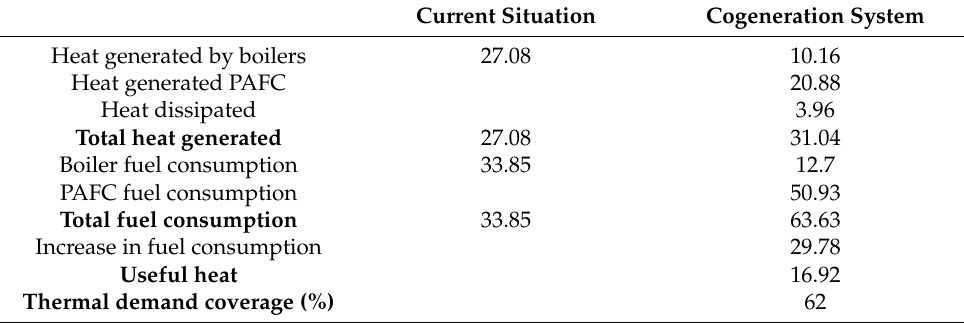
Table 11. Annual thermal energy balance for the chosen alternative (GWh).